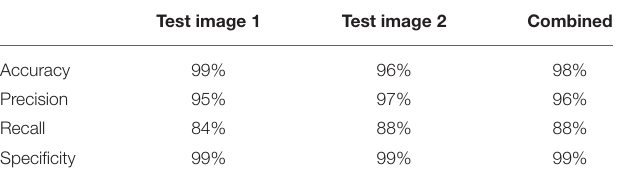
TABLE 1 | Model evaluation metrics.